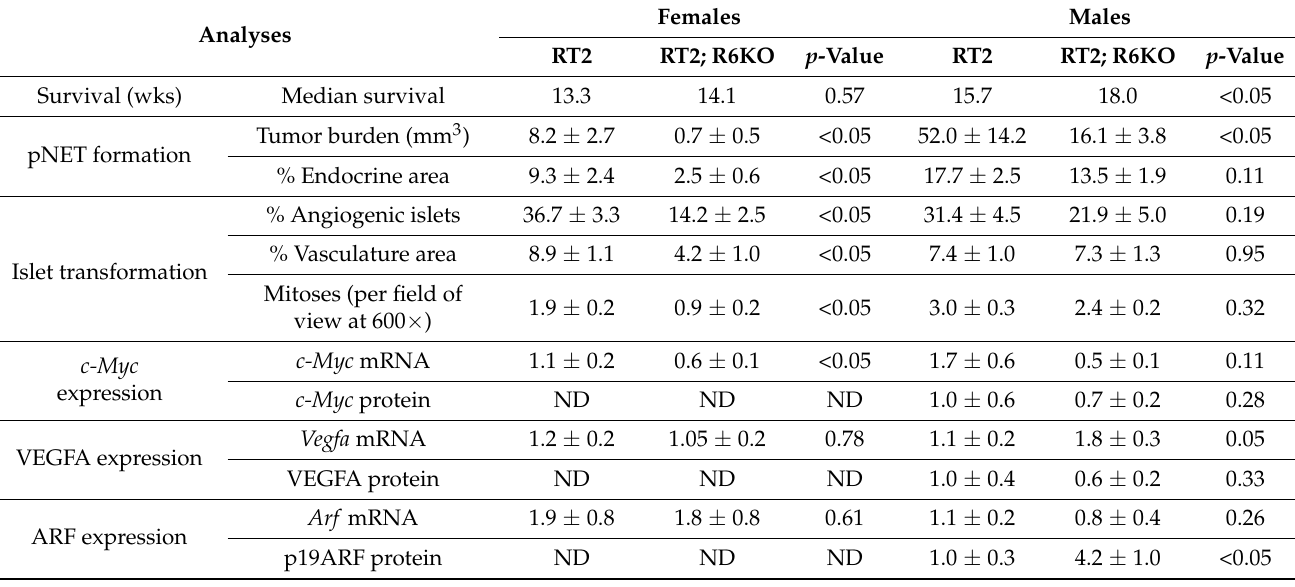
Table 1. Summary of biological effects caused by RABL6A loss in RT2